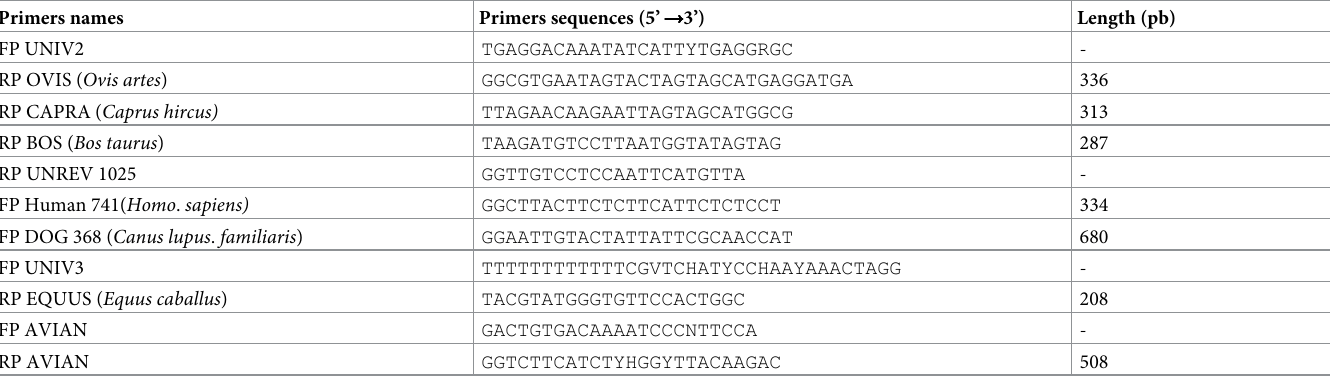
Table 1. Primers set used for the identification of blood meal origin in mosquito